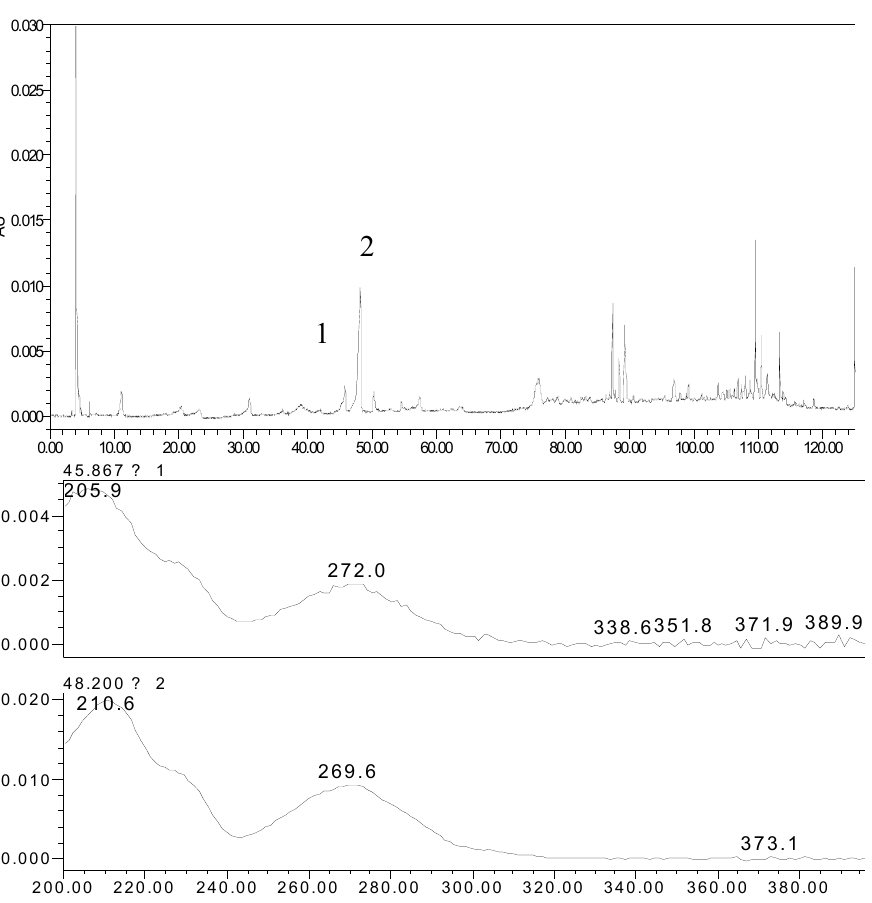
Figure 1. HPLC and UV spectra of the plasma sample after intragastric administration of extract of JZN.